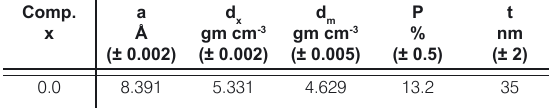
Cr Fe O x x 2-2x 4 ), bulk density (d x